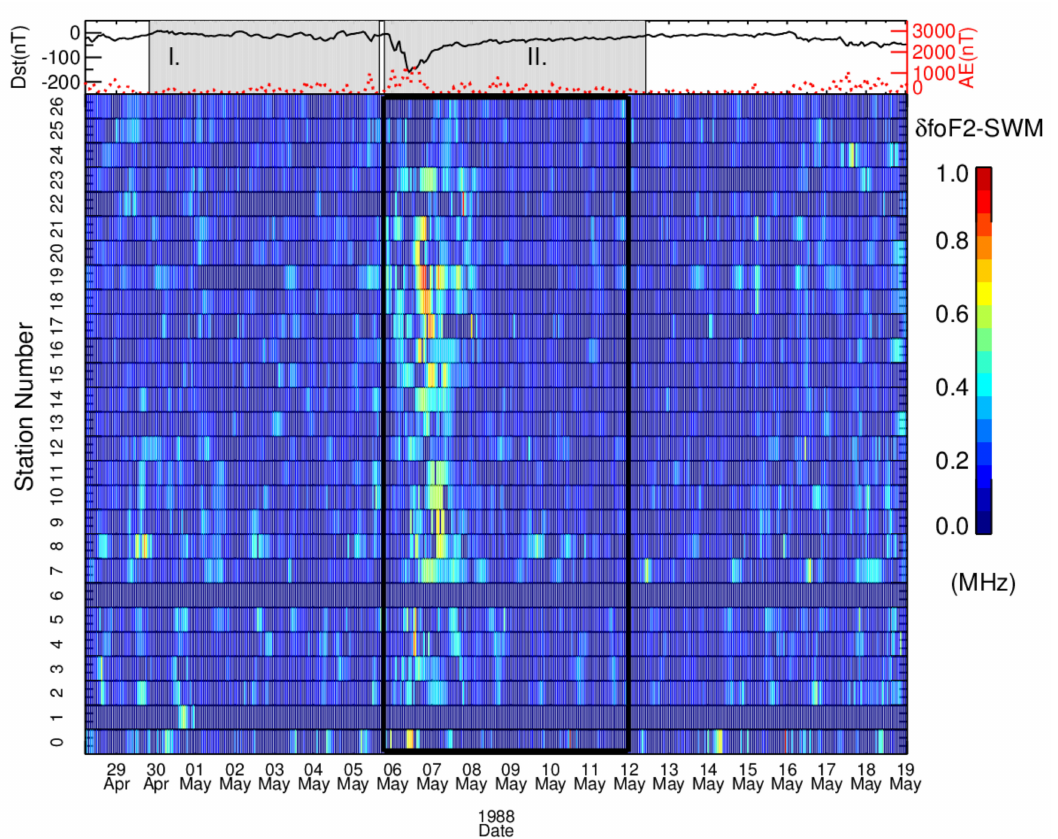
Figure 1. Temporal variation in geomagnetic indices Dst, AE (upper panel), and δ foF2-SWM (color blocks in the lower panel) for 27 ionosondes during the period 29 April to 18 May